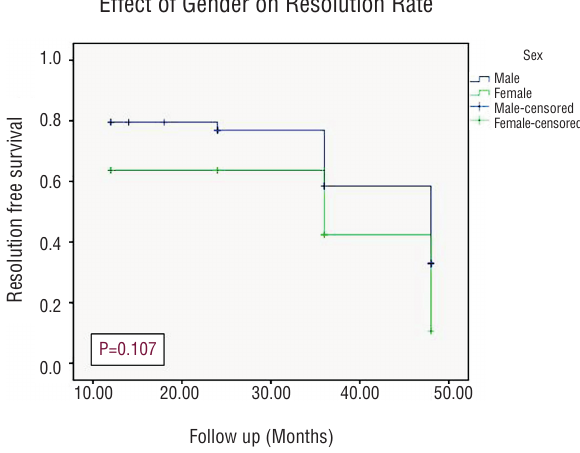
figure 3 - Kaplan-Meier curve Showing Incidence of Resolution Stratifying By Side of HN.